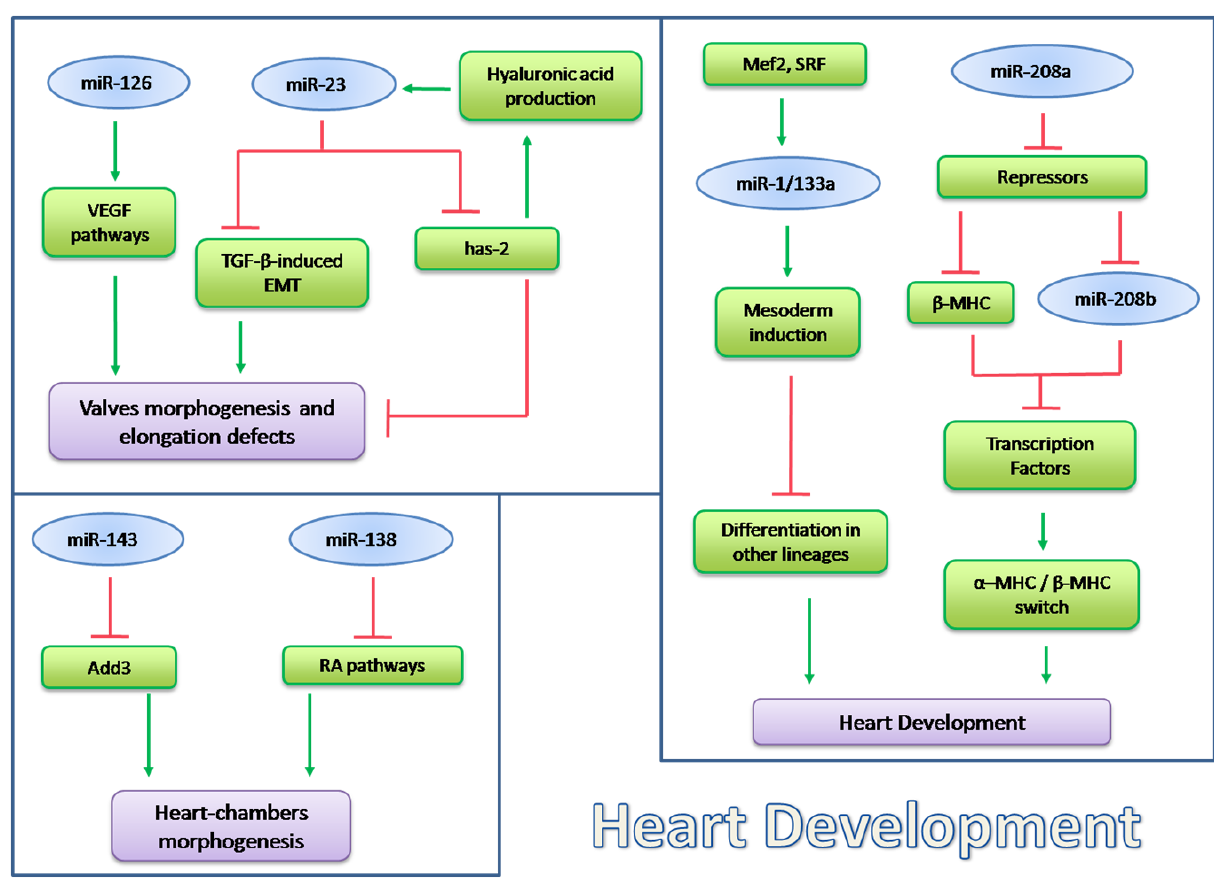
Figure 2. miRNAs involved in Heart Development. Schematic representation of